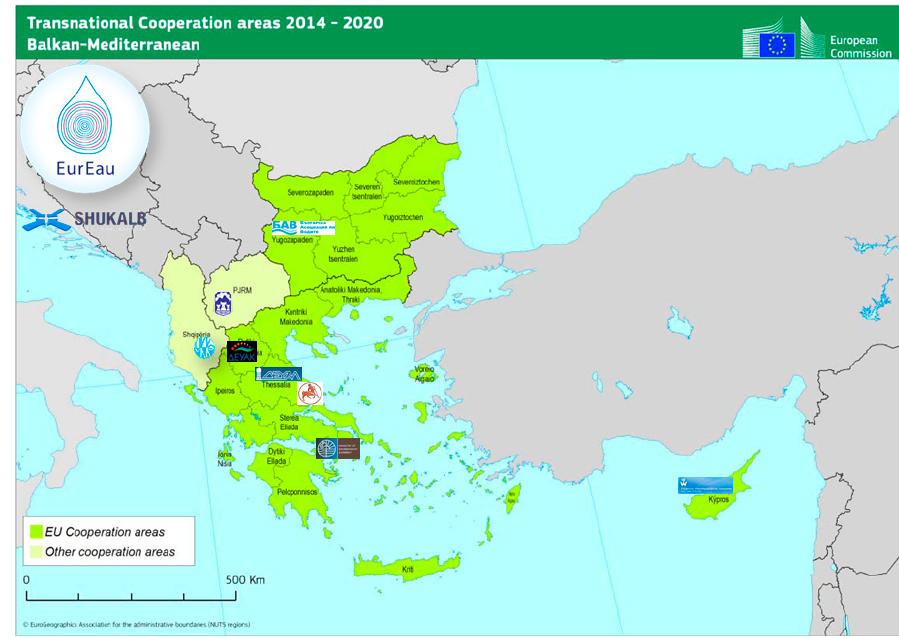
Figure 1. WATenERgy CYCLE partners within the context of Balkan Med